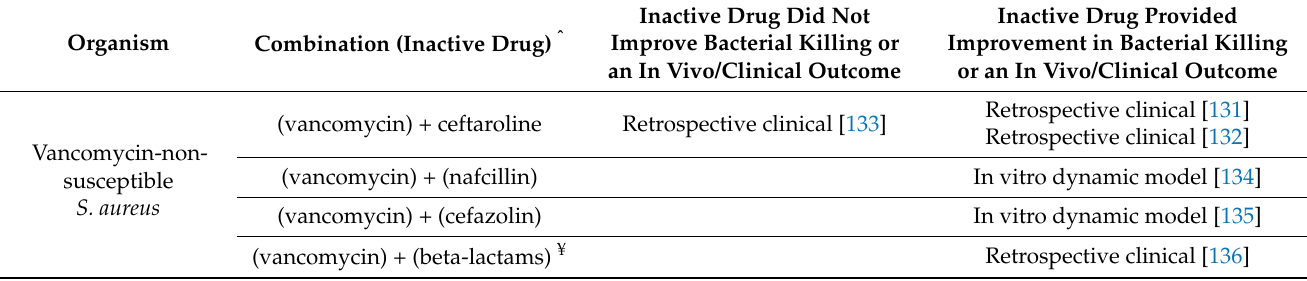
Table 4. Summary of studies that investigated antibacterial combinations against S. aureus that included at least one drug that was inactive individually. Studies are reported in the table if the combination was investigated using a dynamic in vitro model, an in vivo model, or the investigation was completed in the clinic. Susceptibility studies, checkerboard analyses, and static time-killing experiments are not reported in the table due to the preliminary nature of the experiments and the extensive combinatorial permutations that are difficult to summarize